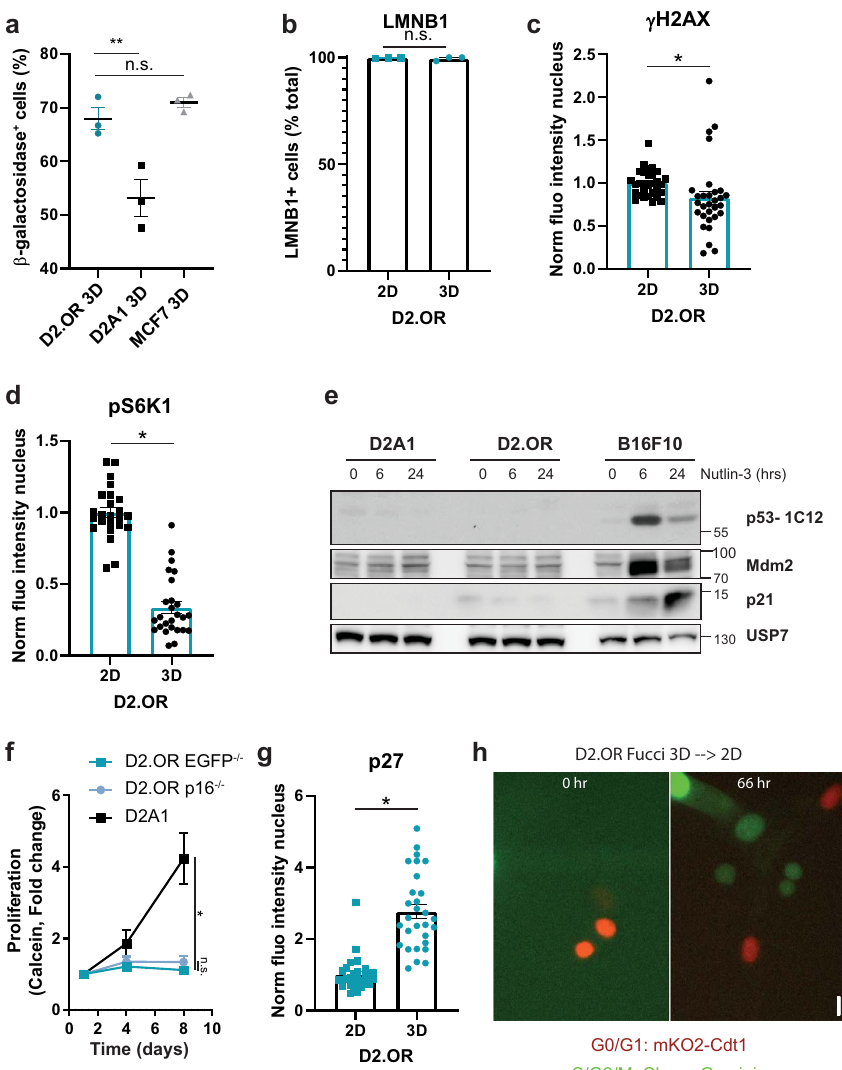
Fig. 4 D2.OR cell cycle arrest in 3D is associated with dormancy and not senescence. a Quanti fi cation of the percentage of β -galactosidase + cells cultured for four days in 3D. MCF7 was used as a senescence control. N = 3 replicates. b Quanti fi cation of the percentage of LMNB1 + cells by immuno fl uorescence cultured for four days in 2D or 3D conditions. N = 3 replicates, each ≥ 12 cells. c Quanti fi cation of immuno fl uorescence nuclear γ H2AX staining intensity of D2.OR cells cultured for four days. Replicates normalized to 2D. N = 30 fi eld of view (FOV) of three replicates. d Quanti fi cation of pS6K1 immunostaining of D2.OR cells cultured in 2D or 3D. Replicates are normalized to 2D. N ≥ 24 fi eld of view (FOV) of three replicates. e Immunoblot analysis of lysates from indicated cell lines cultured in 2D and treated with Nutlin-3 [10 μ M] for 0, 6, or 24 h. f Quanti fi cation of proliferation of indicated cell lines cultured for eight days in 3D. Replicates were normalized to day 1. N = 3 replicates, in duplo. Time × Cell line, F (4, 27) = 10.68. P = ****. Post hoc test, day 8, D2A1 vs others P = *, D2.OR EGFP vs P16-/- P = n.s. g Immuno fl uorescence quanti fi cation of the normalized fl uorescence intensity in the nucleus of D2.OR cells grown for fi ve days in 2D or 3D. N = 3 replicates, each 10 FOV. h Microscopy images of a time series of D2.OR Fucci cells in 2D. Cells were cultured in 3D for four days, extracted, replated in 2D, and imaged. Scalebar, 30 μ m. P values were calculated using 1-way ANOVA, nested T -test or mixed-effect analysis. Error bars,